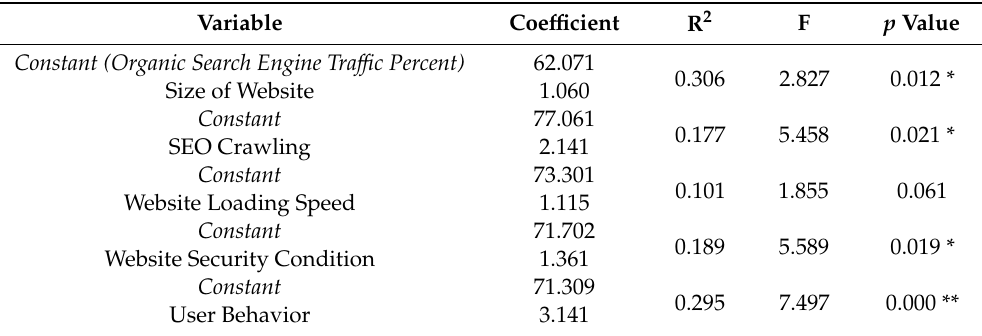
Table 3. Regression analysis